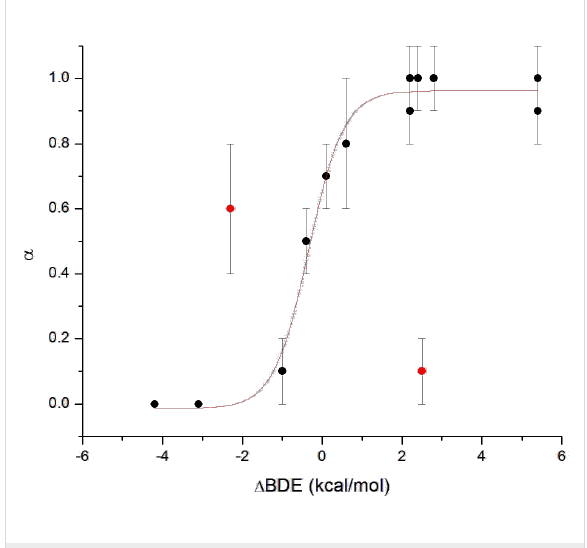
Figure 5: Regeneration efficiencies ( α ) observed in autoxidations of styrene in chlorobenzene (50% v/v) at 303 K inhibited by co-antioxi- dant mixtures as a function of the difference in the O–H BDEs of the principal (AH) and co-antioxidant (Co-AH) [ Δ BDE = BDE(AH) – BDE(Co-AH)]. The data highlighted in red correspond to the combina- tions of 9c / 12 and 4c / 11 .